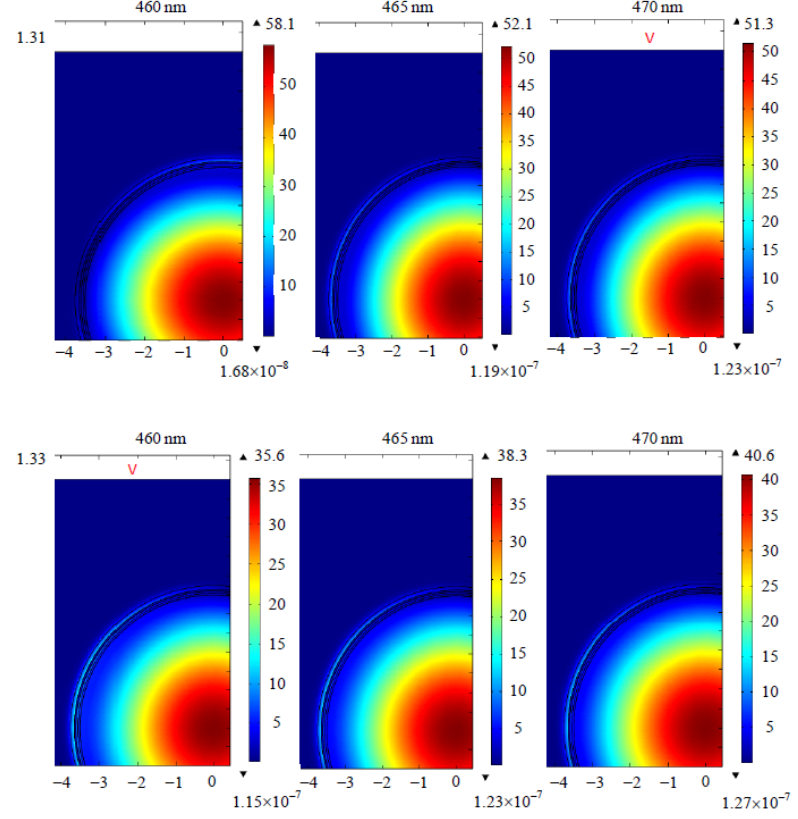
Fig. 7 Effective RI with analyte RI variation from 1.31 to